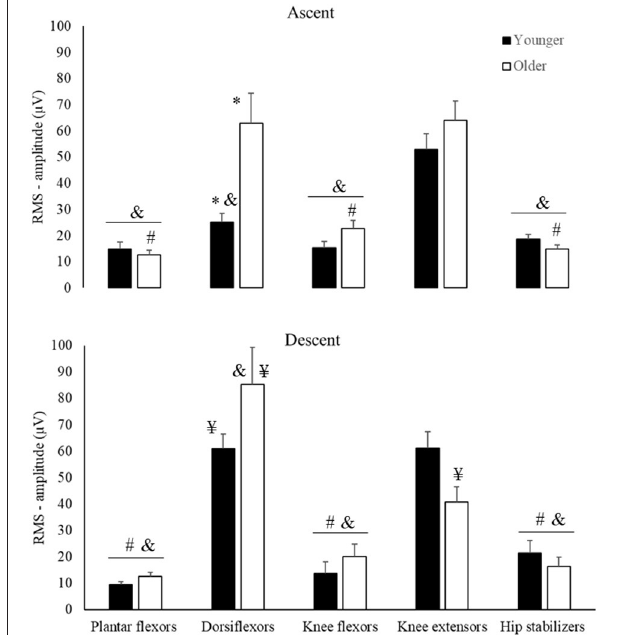
FIGURE 3 | Means and Standard Errors for RMS-amplitude (Y-axis) for younger (filled columns) and older (open columns) adults by muscle groups (horizontal axis) and phases of the sit-to-stand task (Ascent, Descent). *Age differences; # muscles that are different from dorsiflexors; & muscles that are different from knee extensors; U descent differs from